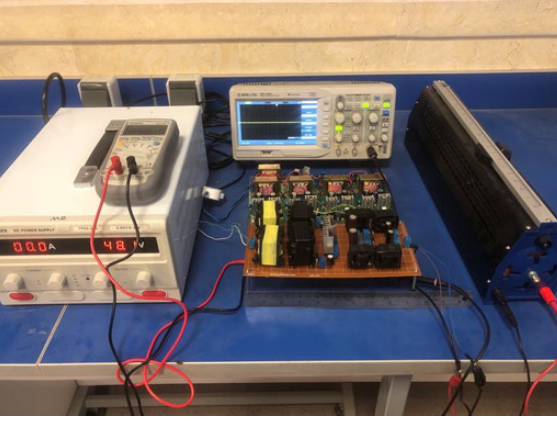
Figure 8. Simulation waveforms of the proposed converter: ( a ) voltage and current of switch M 1 , ( b ) Figure 9. Experimental setup of the proposed converter. voltage and current of diode D 4 , ( c ) voltage and current of diode D 2 , ( d ) voltage of capacitors C 3 and C 4 , ( e ) current of inductors L 5 and L 6 , and ( f ) current of inductors L 7 and L 8 .